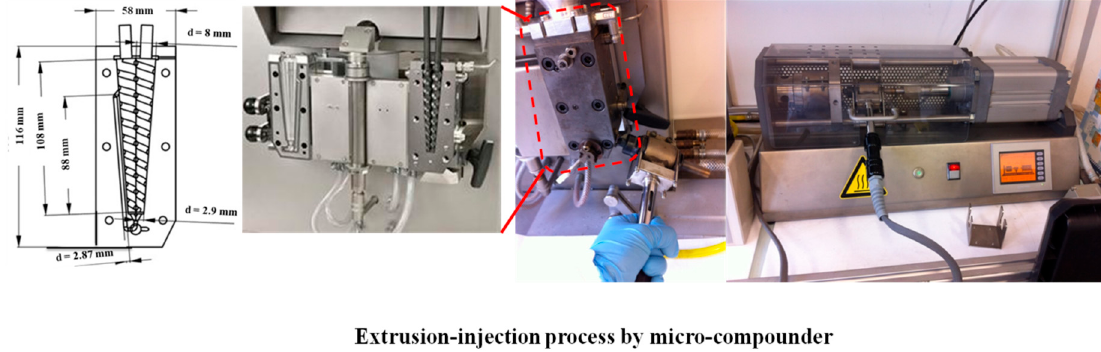
Figure 1. The process of preparing samples by micro-compounder.